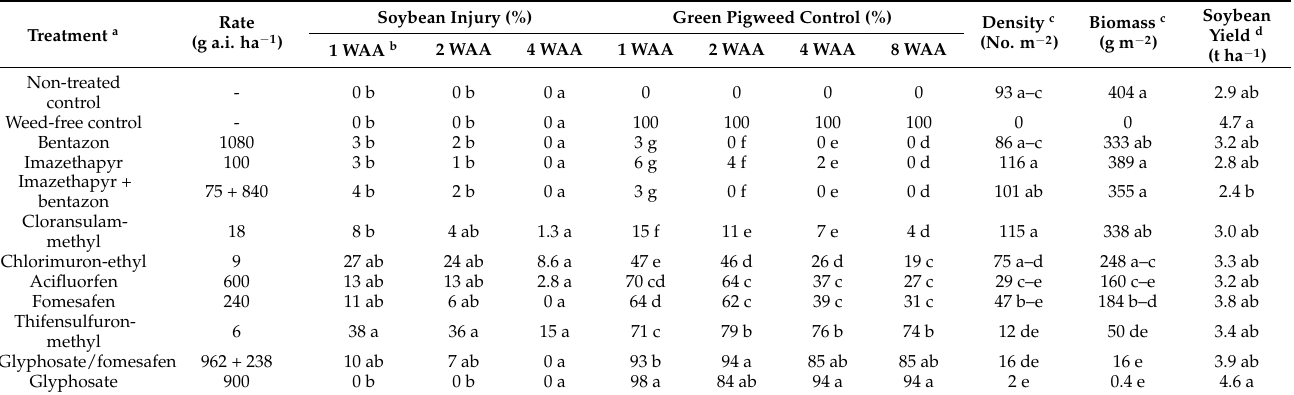
Table 6. Visible green pigweed ( A. powellii ) control, density, biomass, and soybean yield as impacted by POST herbicide treatments from two field trials conducted in 2019 and 2020 near Dresden,